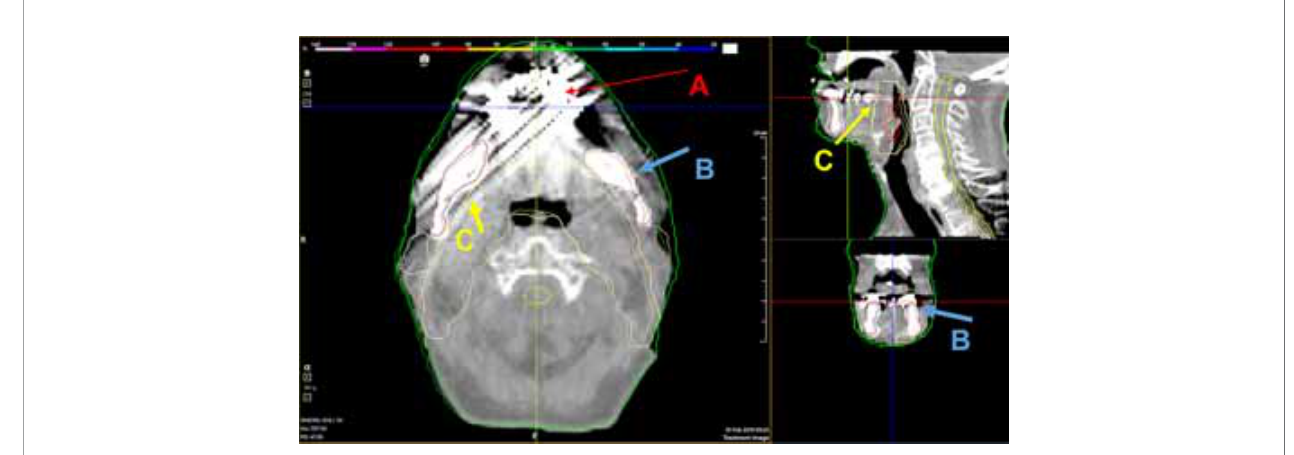
FIGURE 6 | A demonstration of the deformable algorithm ’ s ability to account for severe CBCT dental implant artifacts [red arrows, (A) ]. The blue (B) and yellow (C) arrows indicate the deformed mandible and PTV contour, respectively. Both were minimally affected by the streak